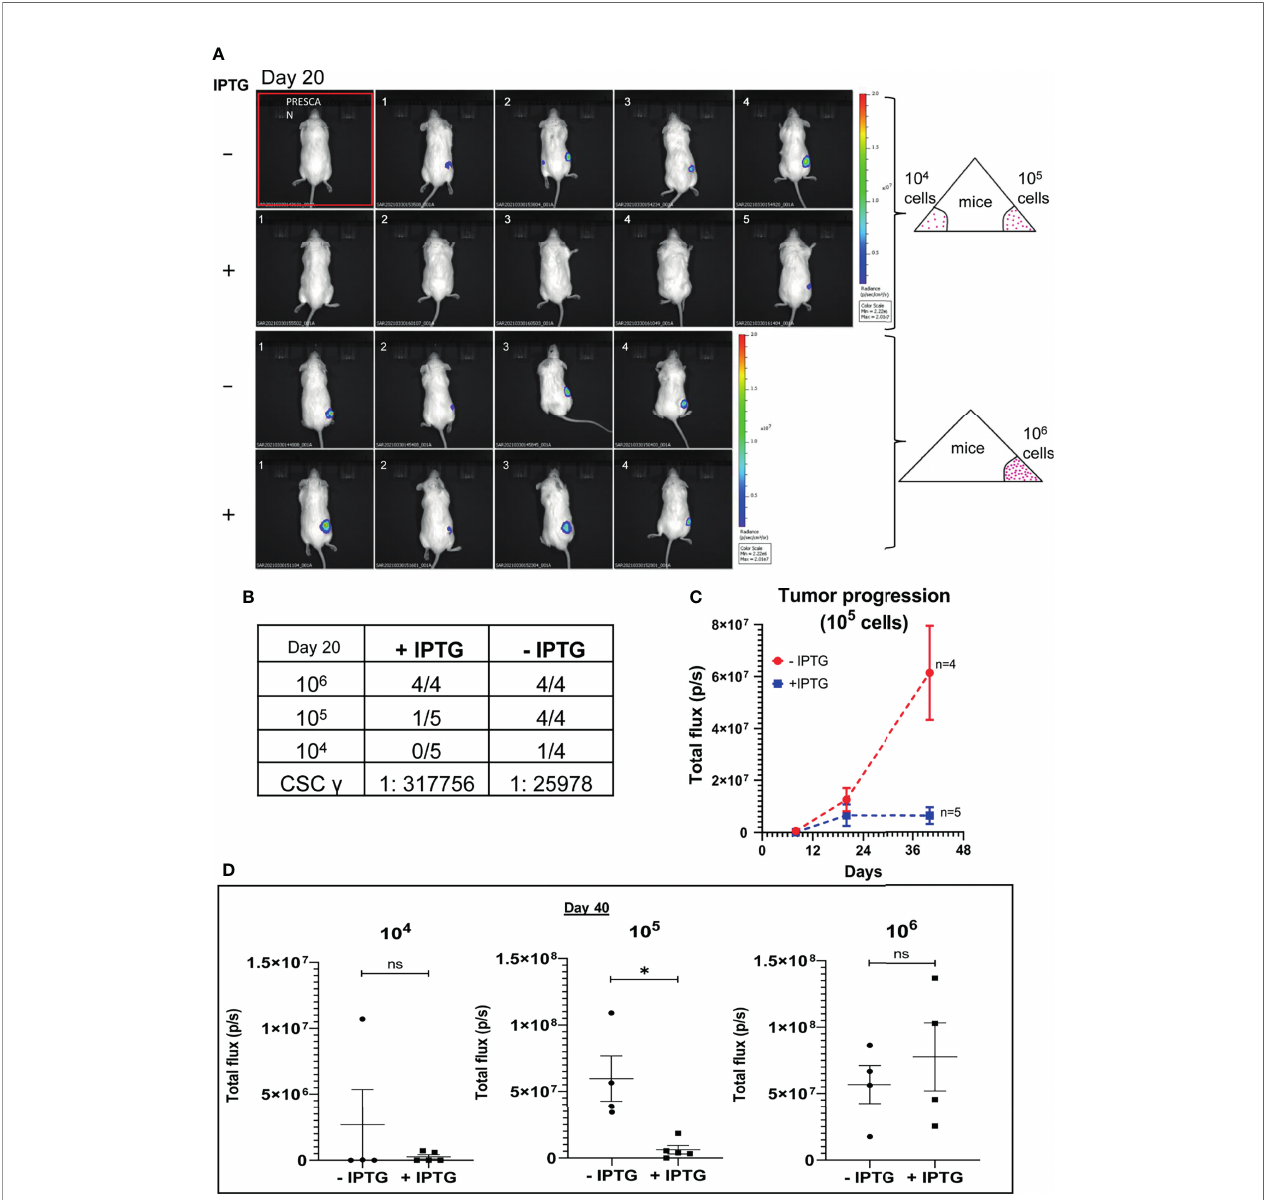
FIGURE 2 | TUBB4B downregulation affects tumor initiation potential in mice xenograft. HSC-3 cells stably expressing Luciferase gene were transduced with lentivirus carrying inducible TUBB4B shRNA. The cells were split into two groups, and either induced with 50mM IPTG for 15 days to downregulate TUBB4B or were left uninduced. Post validation of downregulation by western blotting, serial dilutions of cells, 10 4 , 10 5, and 10 6 were injected into fl anks of NOD.CB17- Prkdc SCID /J mice to generate xenografts. IPTG treatment was continued for another seven days for the induced animals. The tumor growth was assessed by measuring the bioluminescence at days 8, 20, and 40 post the cell injection. (A) shows the bioluminescence image and (B) summarizes the tumor initiation observed 20 days post cell injections along with the CSC frequency calculated using ELDA. A total fl ux minimum value of 2x10 6 p/s was considered as the cutoff for tumor detection. (C) is a graphical representation of the tumor progression observed over a period of 40 days in the animals injected with 10 5 cells. (D) is the graphical representation of the luminescence in total fl ux measured in the different dilution groups at day 40. ns represent non-signi fi cant data, and * represents p-value <